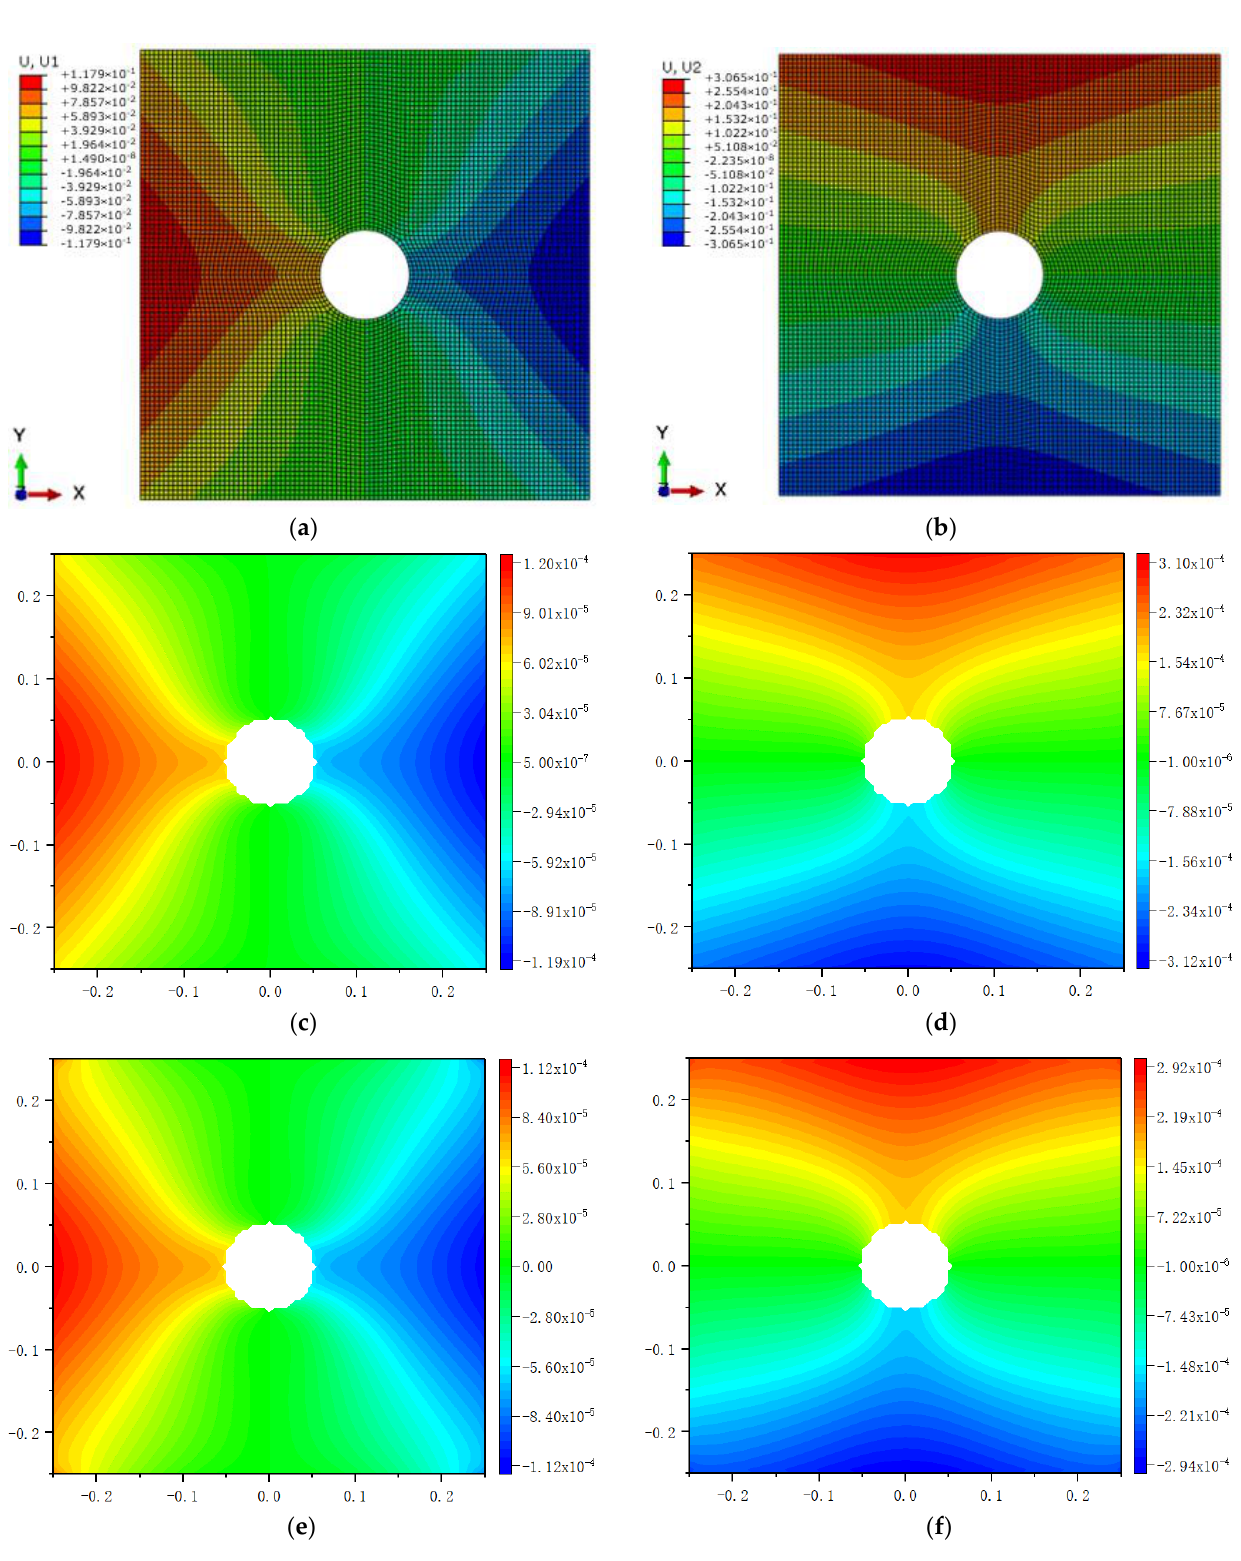
Figure 20. The distribution of displacement in the plate with central circular hole: ( a ) u x calculated by ABAQUS; ( b ) u y calculated by ABAQUS; ( c ) u x calculated by original PD; ( d ) u y calculated by original PD; ( e ) u x calculated by Equation (7); ( f ) u y calculated by Equation (7).